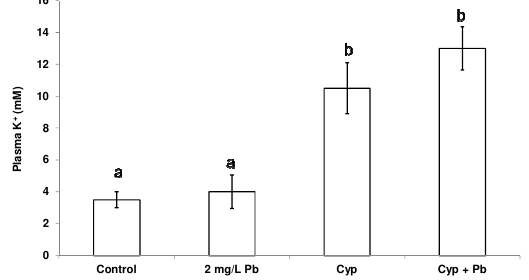
Fig. 3. Mean (±SE, n=6) plasma K + in C. gariepinus exposed to either borehole water (control), 2 mg/L Pb, 0.5µg/L cypermethrin or 0.5µg/L cypermethrin + 2 mg/L Pb. Bars with different letters are significantly different